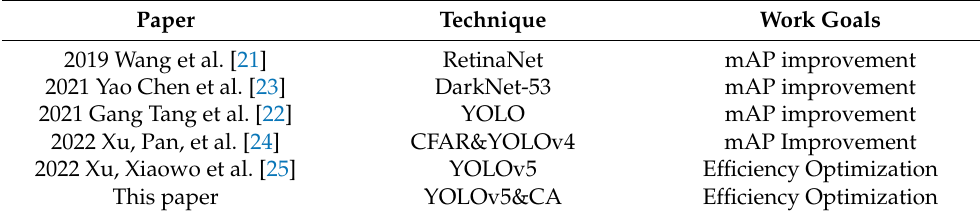
Table 1. The related work discussion on DL-based ship detectors.